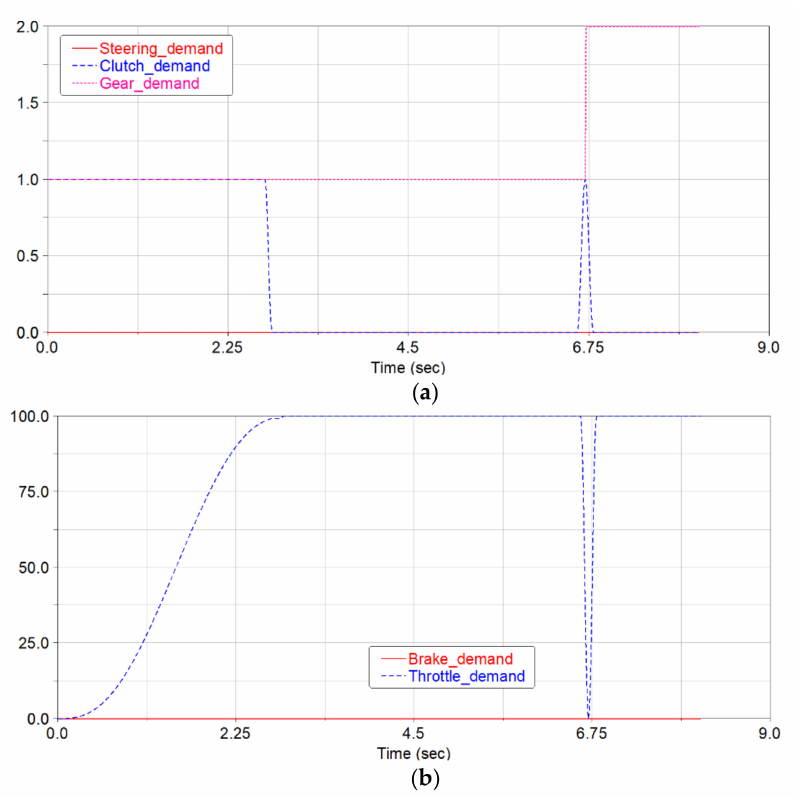
Figure 12. Acceleration Event-Driver input. ( a ): the y -axis shows the steering demand ( ◦ ), the gear ratio, and the clutch demand that varies in the window [0 1]. ( b ): brake and throttle demand ranging between 0 and 100%.